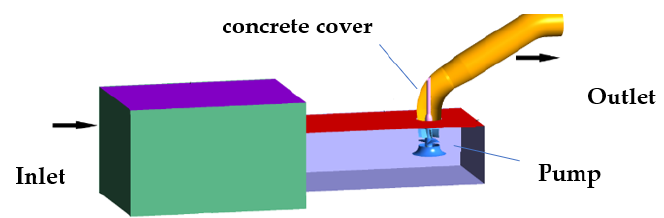
Figure 2. Closed sump for water treatment pumping station.